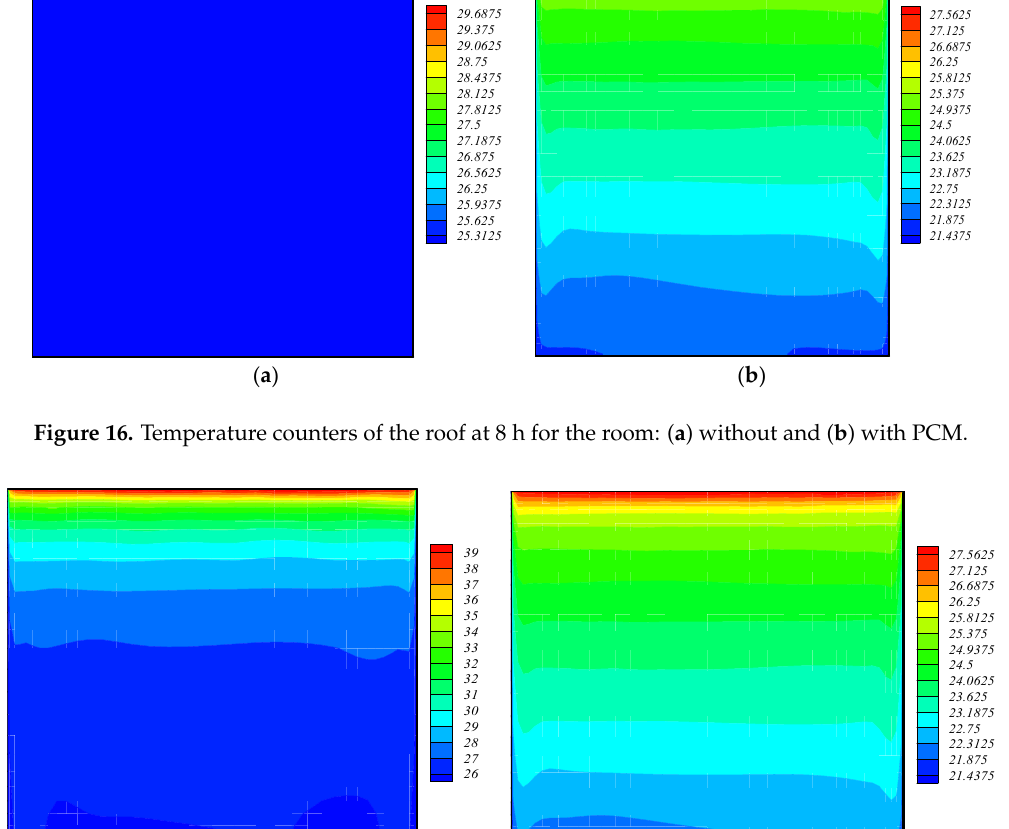
Figure 14. Amount of heat storage in the non ‐ PCM ‐ and PCM ‐ treated west walls. Figure 15. Heat flux through the internal surface of the non ‐ PCM ‐ and PCM ‐ treated west walls. The simulated temperature contours for REF and PCM2 at different times over the day are